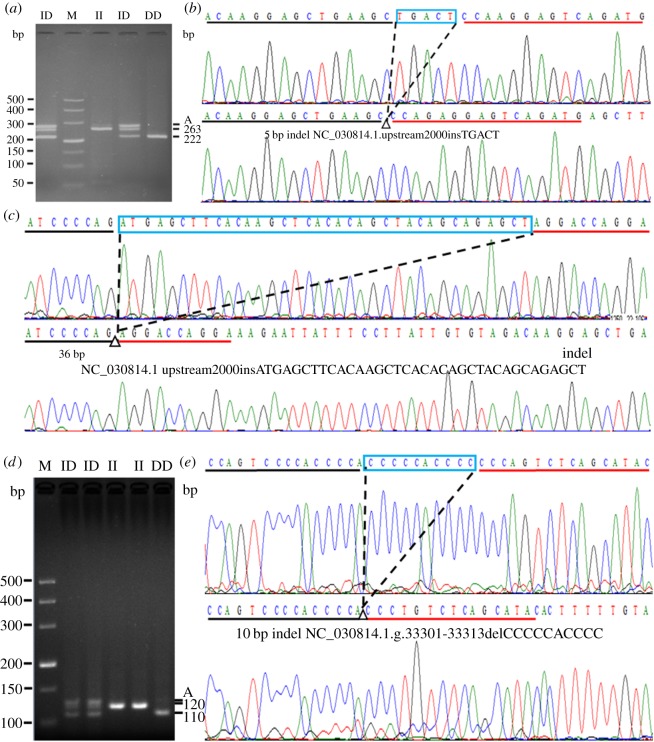
The electrophoresis diagrams and sequence diagrams of goat PDGFRB gene indel loci. (a,b) The 5 bp indel locus, (a,c) the 36 bp indel locus and (d,e) 10 bp indel locus. The letter A indicated a heteroduplex and the triangle symbol (Δ) indicated the location of the insertion/deletion (indel). The underlined nucleotides at the beginning of the sequences represent similarities between the ‘ins’ variant and ‘del’ variant.